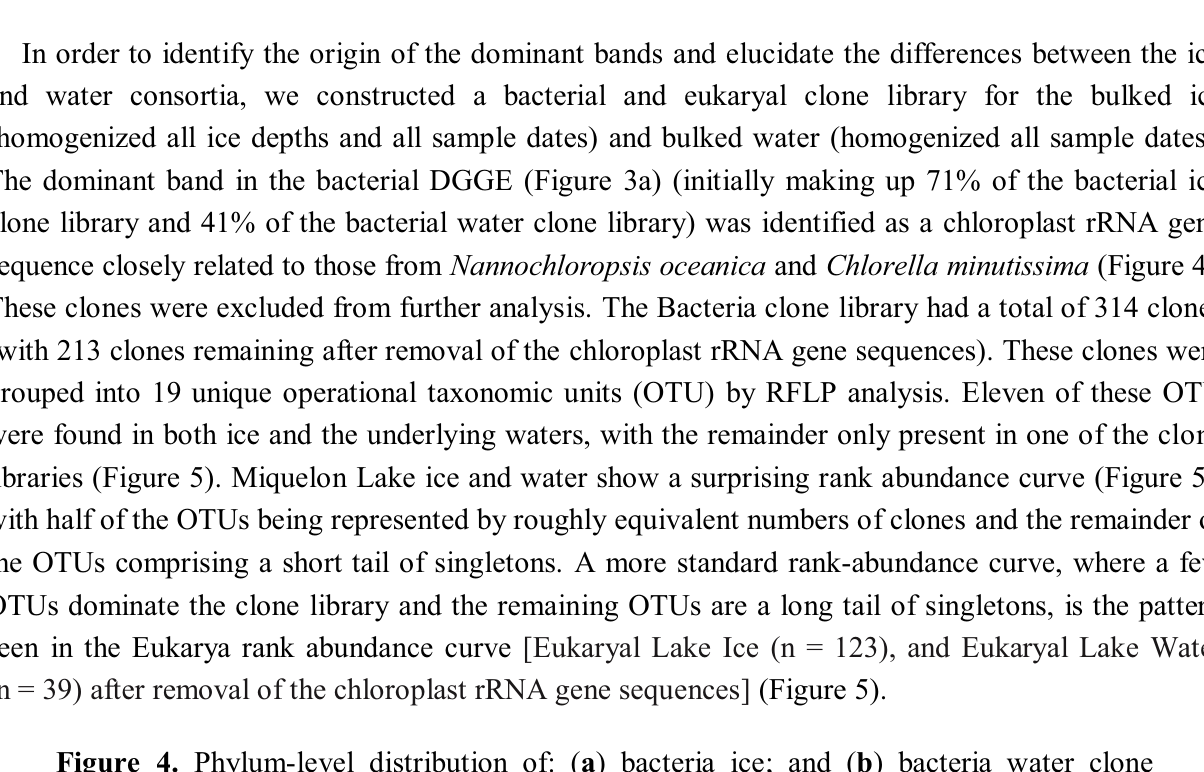
Figure 4. Phylum-level distribution of: ( a ) bacteria ice; and ( b ) bacteria water clone (cid:79)(cid:76)(cid:69)(cid:85)(cid:68)(cid:85)(cid:76)(cid:72)(cid:86)(cid:17)(cid:3) (cid:55)(cid:75)(cid:72)(cid:3) (cid:179)(cid:82)(cid:87)(cid:75)(cid:72)(cid:85)(cid:180)(cid:3) (cid:70)(cid:68)(cid:87)(cid:72)(cid:74)(cid:82)(cid:85)(cid:92)(cid:3) (cid:76)(cid:81) cludes all phyla that were represented by <10 clones in each library (see main text for more details). Chloroplast rRNA gene sequences are separated because they were not included in subsequent